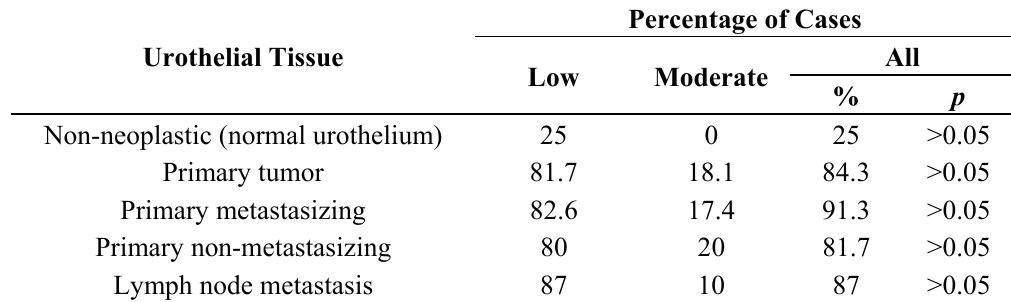
Table 1. Percentages of cases with OCT4A expression within the urothelium.